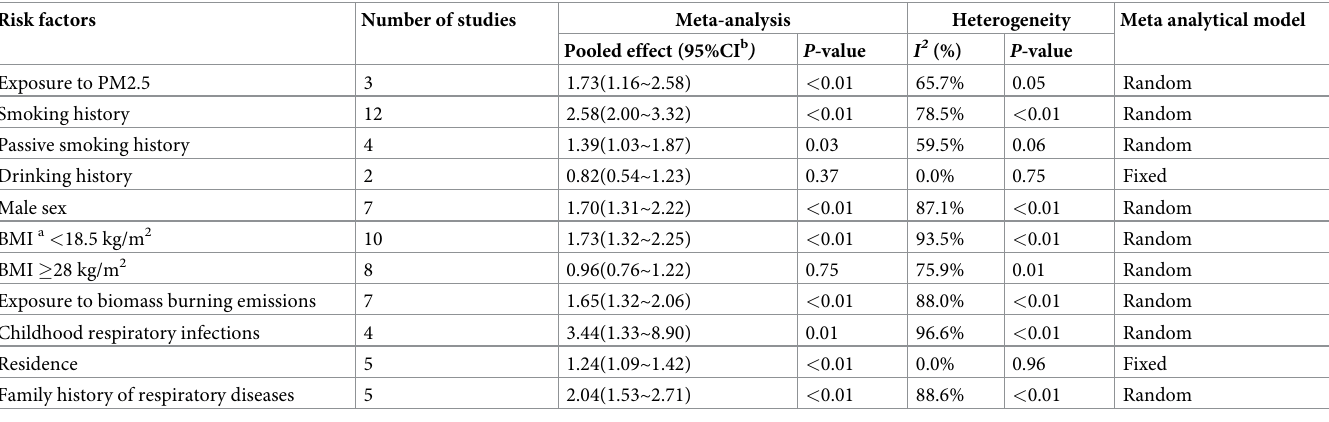
Table 2. Results of meta-analysis and heterogeneity